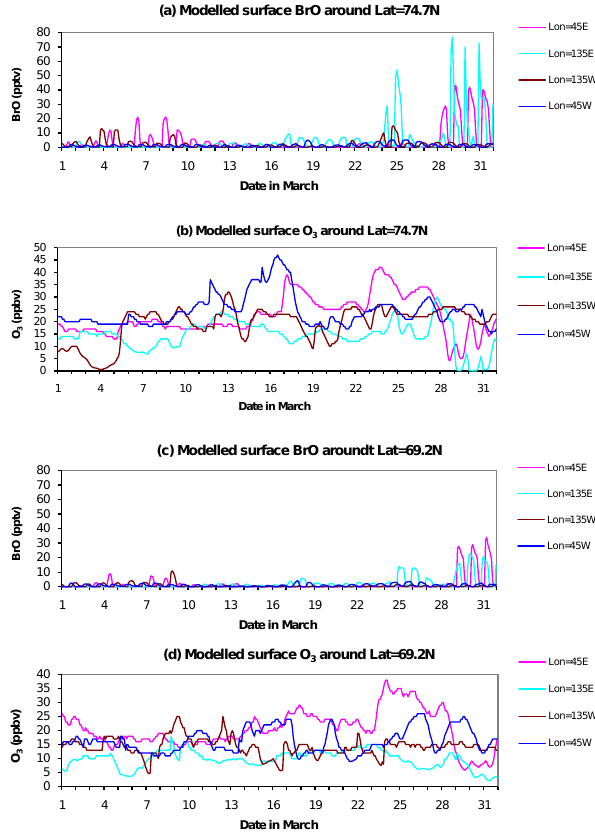
Fig. 7. BASE run surface BrO and ozone mixing ratios at different longitude locations along two model latitudes of 74. ◦ N ( a and b ) and 69.2 ◦ N ( c and d ) in March